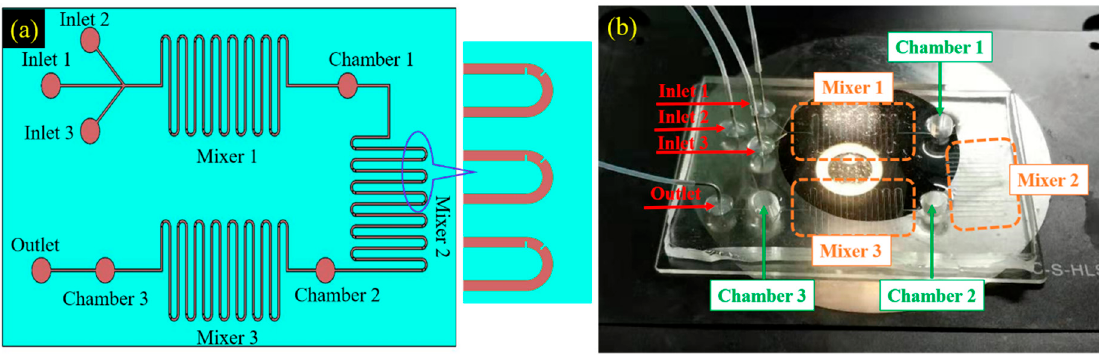
Figure 4. Designed microfluidic chip for exosomes isolation, ( a ) design schematic, and ( b ) fabricated chip.